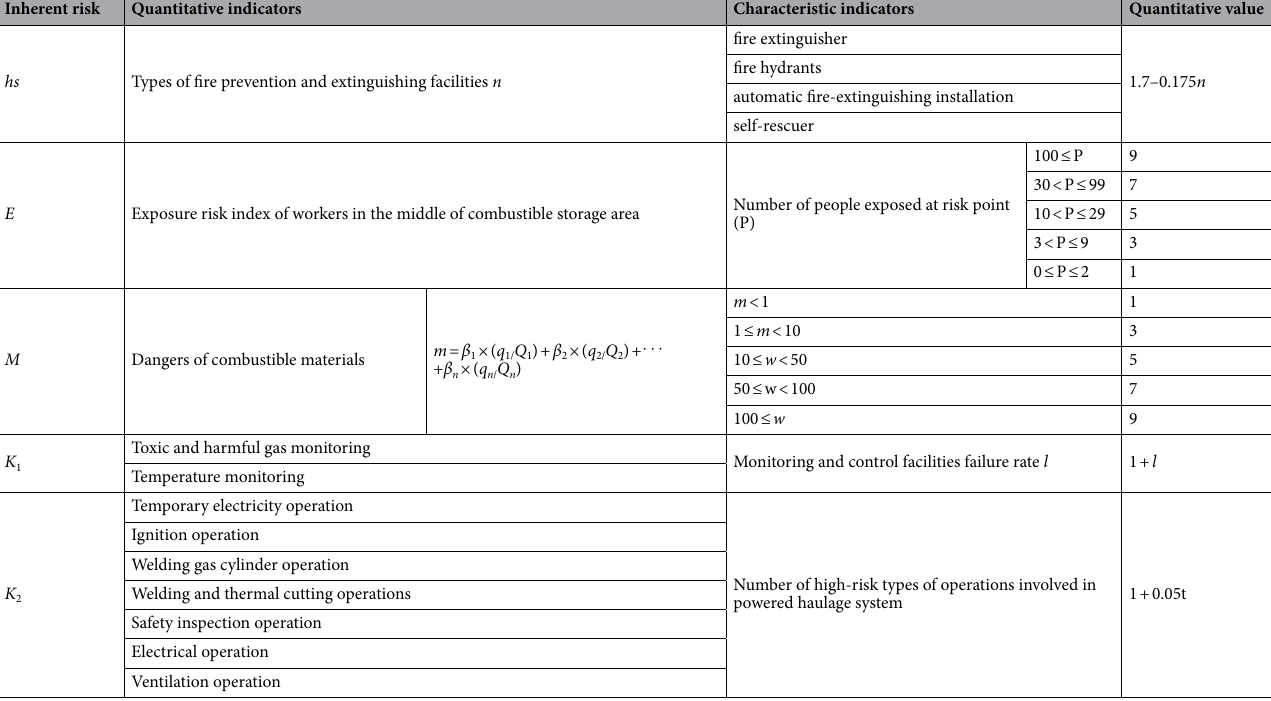
Table 3. Fire accident risk point. where Q 1 , Q 2 , · · · Q n are the critical quantities; q 1 , q 2, · · · q n are the actual storage quantities; and the correction factor β takes the value of